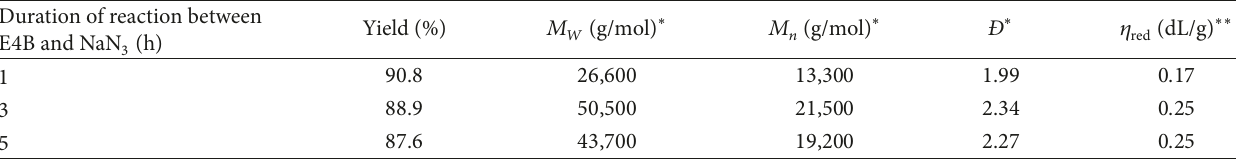
Table 4: The influence of the duration of Step 1 of the one-pot/two-step/three-component process on the characteristics of PE8E4. Duration of reaction between